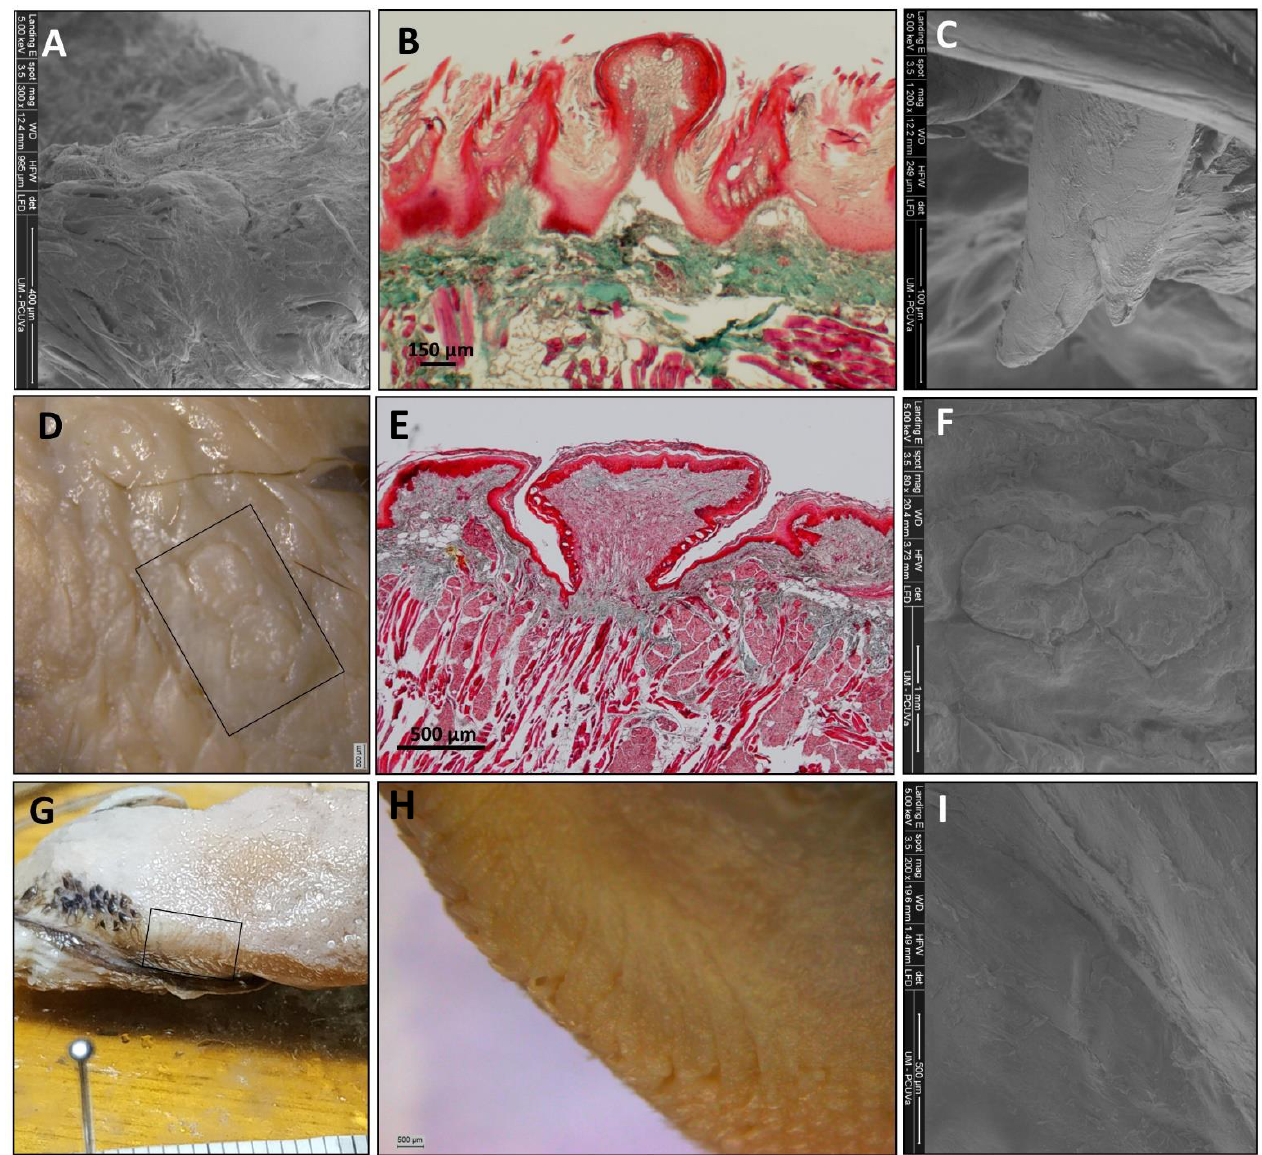
Figure 8. All images correspond to Eulemur macaco papillae. SEM images can be observed of fungiform and filiform ( A ), a conical-like papilla present on the tip of the tongue ( C , magnified from Figure 3—image I right inferior angle), circumvallate and conical ( F ) and foliate ( I ). Also presented are Masson trichrome-stained images of filiform ( B ) and circumvallate ( E ) papillae. Optical images of circumvallate papillae ( D , from the posterior branch of the Y-shaped disposition) and foliate papillae ( G , H ). Image ( D , F ) correspond to the same sample. The minor division of the scale in image ( G ) corresponds to one millimeter .